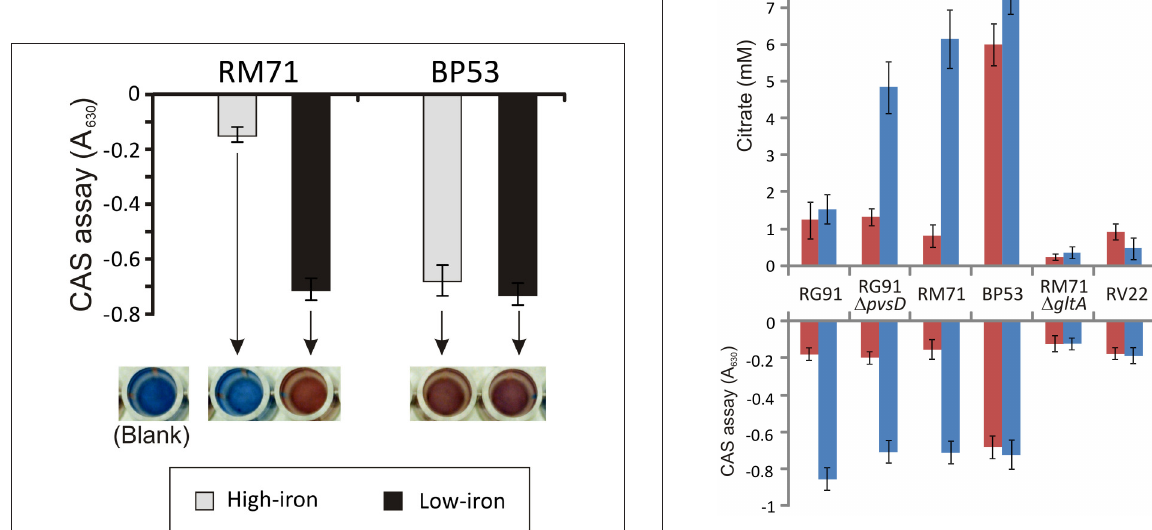
FIGURE 1 | CAS assay of cell-free supernatants obtained from RM71 and BP53 mutant cultures at OD 600 = 0.6 under high- and low-iron conditions. Each bar represents mean values from three replicates. Error bars indicate standard deviations. Color pictures show wells from a microtiter plate with representative CAS test results.